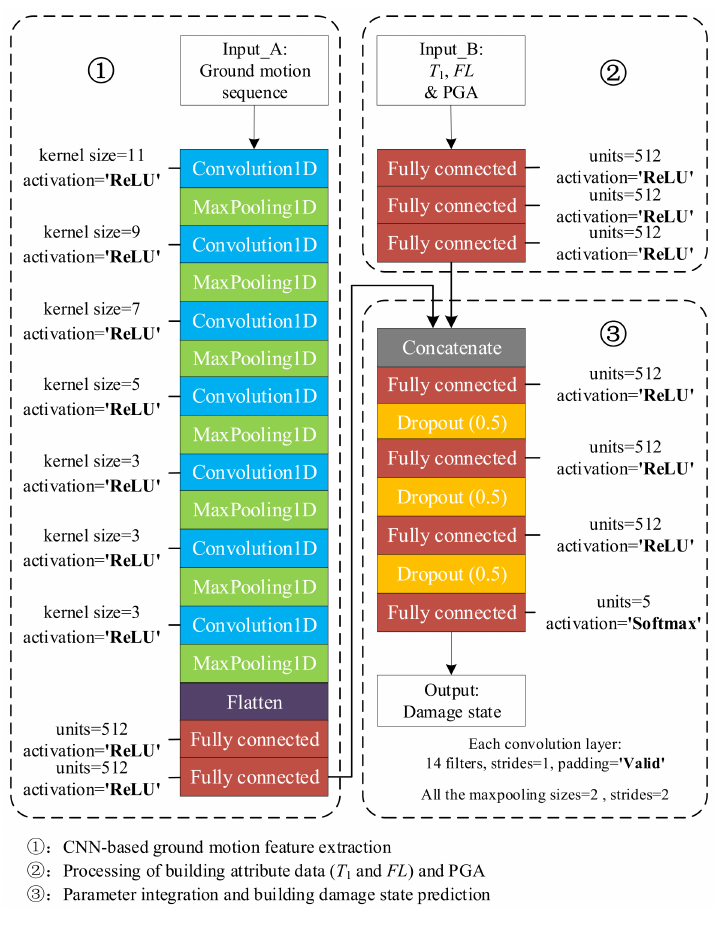
Figure 2. Schematic diagram of the MI-CNN